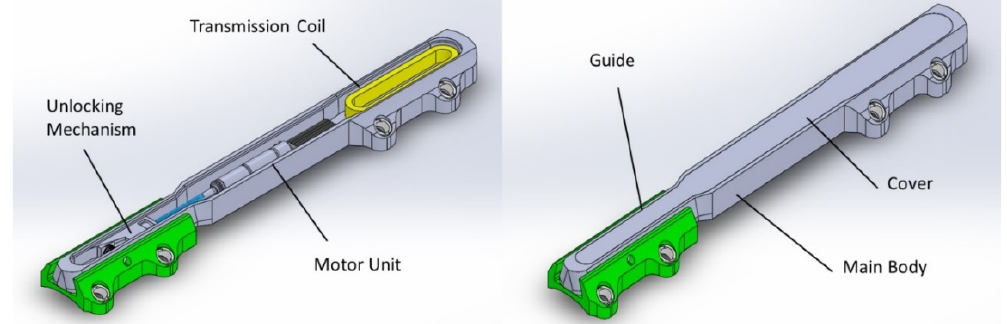
Figure 3. Refined design of the plate: detail of internal and external components.